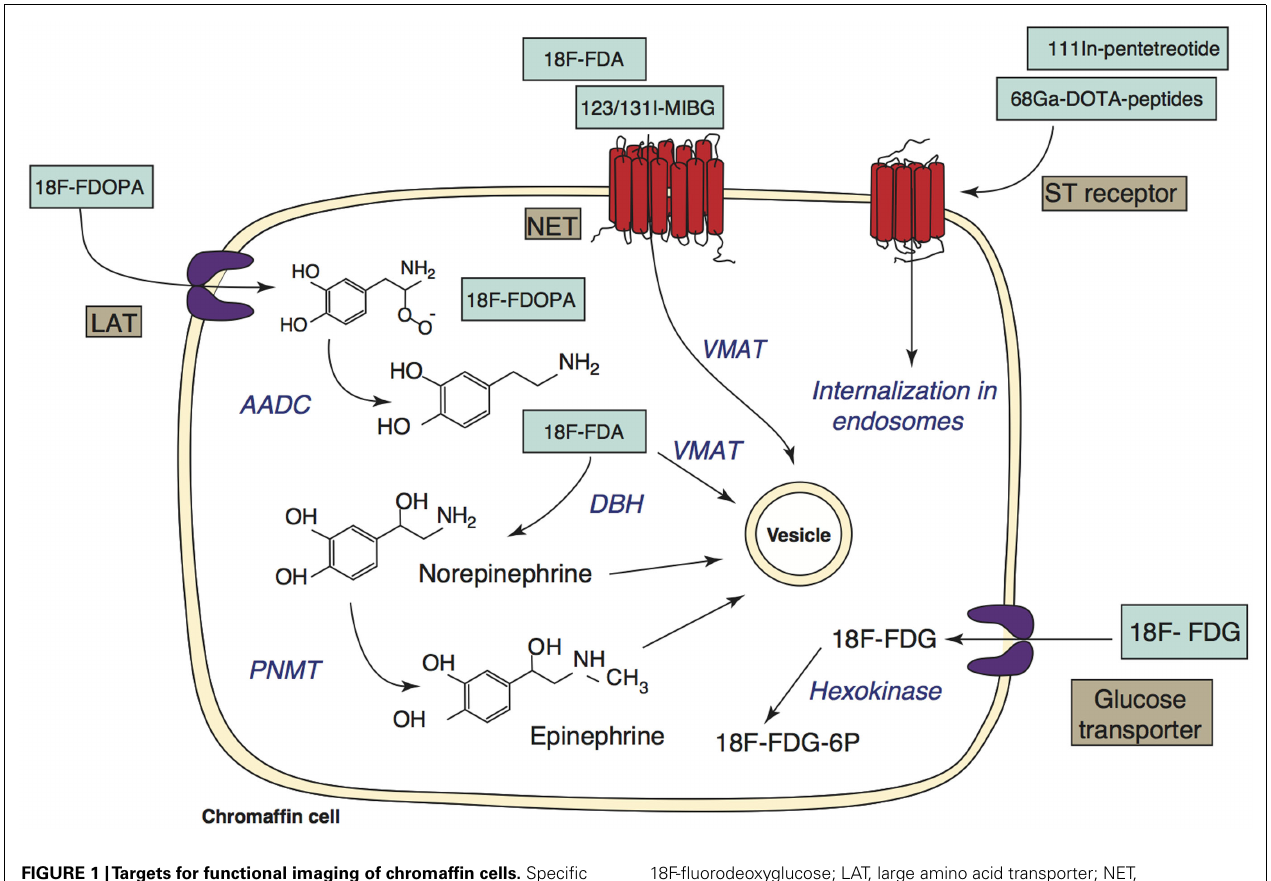
FIGURE 1 |Targets for functional imaging of chromaffin cells. Specific targets involved in the metabolism of catecholamines are shown on the left of the image. Less specific targets are shown on the right. Abbreviations: 18F-FDA, 18F-fluorodopamine; 18F-FDOPA, 18F-fluorodihydroxyphenylalanine; 123/131I-MIBG, 123/131I-metaiodobenzylguanidine; 18F-FDG,